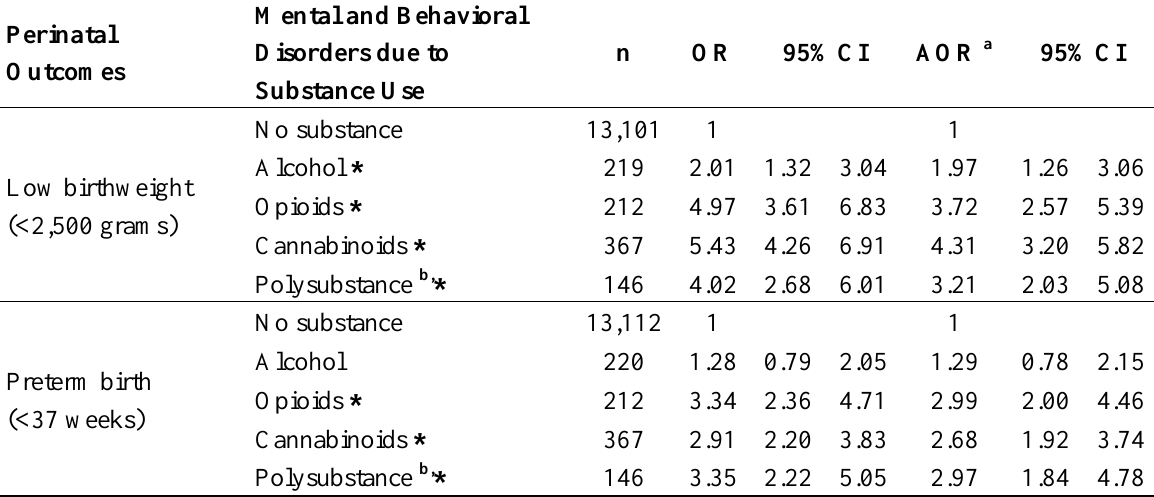
Table 1. Mental disorder due to alcohol, opioids or cannabinoids and perinatal